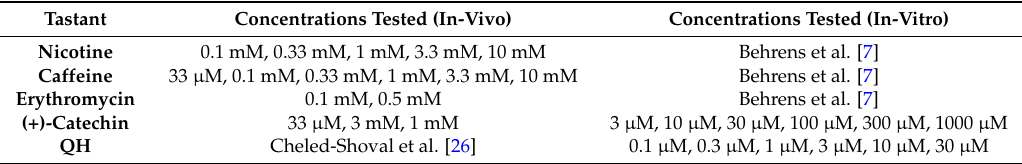
Table 2. List of Tested Compounds and Concentrations of the Tastant